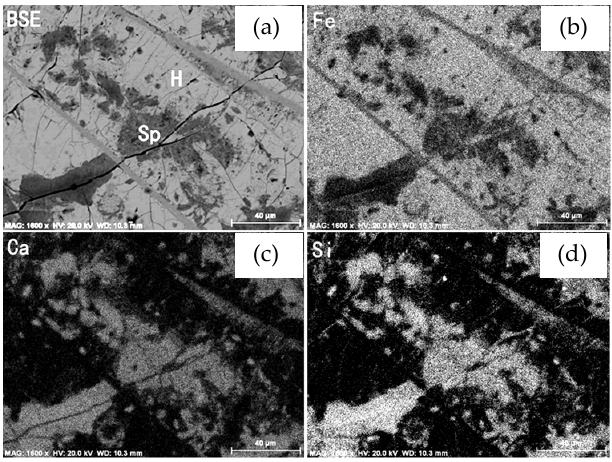
Figure 2. SEM images of vanadium-titanium magnetite replaced by sphene: ( a ) Back-scattered electron image; ( b ) Fe element mapping; ( c ) Ca element mapping; ( d ) Si element mapping.